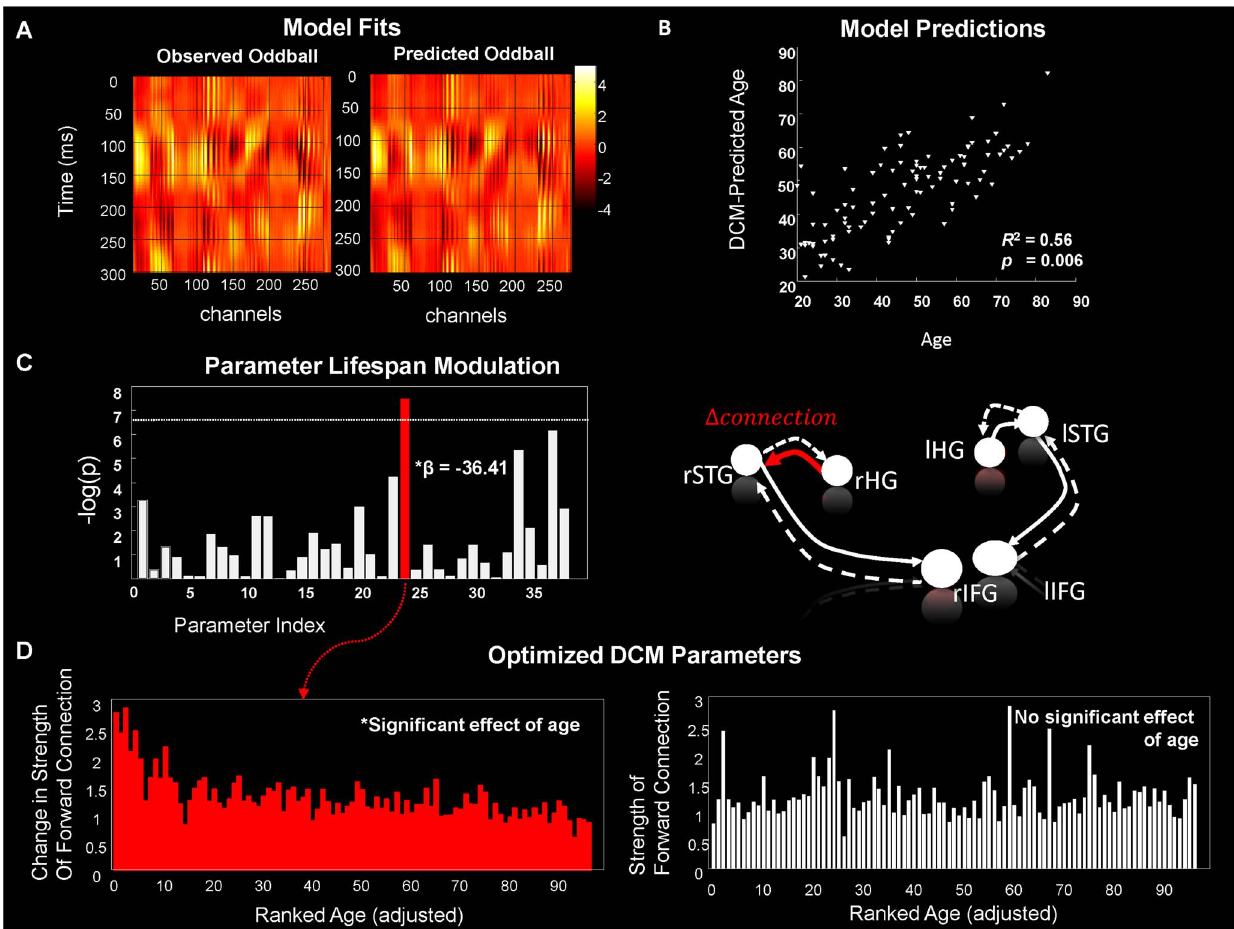
Figure 3. Age Effects from DCM’s Neuronal Parameters. A) Representative example of data fit shown as a sensor space image for all MEG channels (along the x-axis) over peristimulus time (0–300 msec along the y-axis). Data are normalized to arbitrary units according to color bar. B) Subjects age as predicted by a linear regression on the DCM neuronal parameters. C) Left: Contribution of each parameter to the regression: negative log p -value for all 38 regression coefficients (37 DCM parameters and a constant; Table 1) as assessed using the appropriate t -statistic. The horizontal line depicts the Bonferroni-corrected significance level. One parameter has a significant p -value: this parameter encoded the difference in forward connectivity to right STG, between oddballs and standard and had a negative correlation with age. Right: Red is the forward connectivity parameter, illustrated within the DCM architecture, where age was predicted. D) Individual DCM parameter estimates. Left: the parameter controlling changes in connectivity from right HG to right STG identified above, plotted according to an adjusted (for the effect of remaining parameters in the regression model} age ranking. Right: a similar plot illustrating the latent connectivity strength from right HG to right STG, plotted according to age rank, adjusted as above.